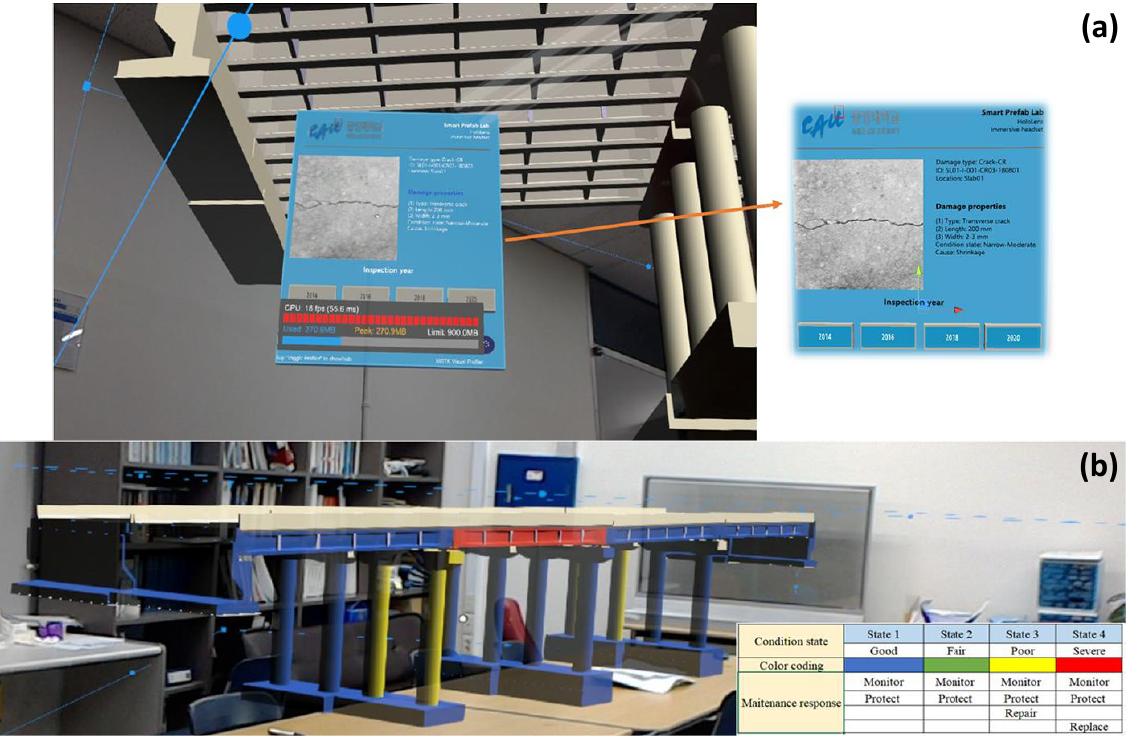
Figure 22. ( a ) Damage visualization and ( b ) condition rating visualization of bridge structure in HoloLens [130].